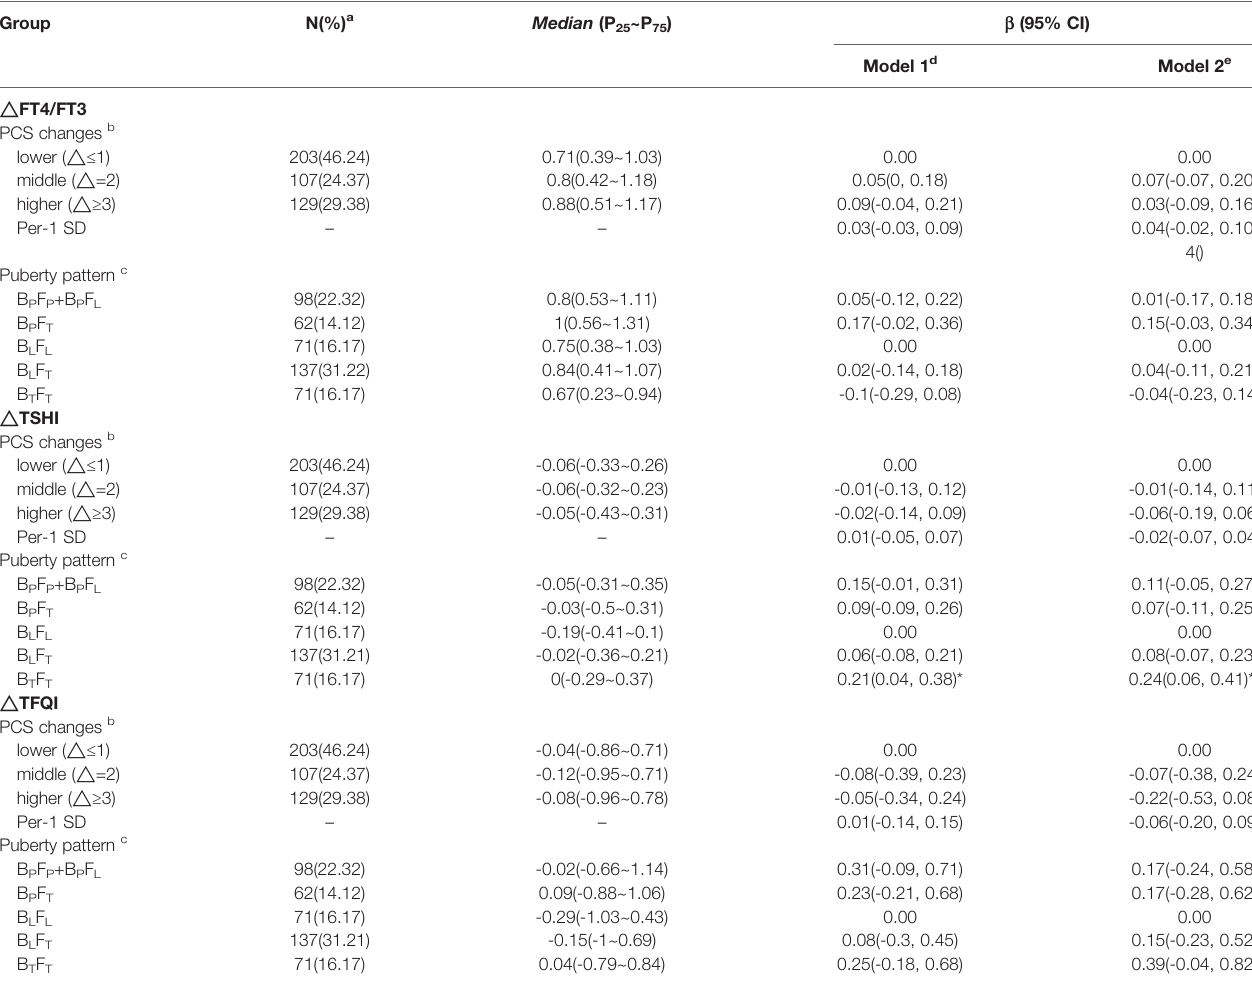
TABLE 4 | b and 95% con fi dence interval (95% CI) for changes in thyroid homeostasis structure parameters ( △ THSPs) according to puberty development by multiple liner regression analyses.